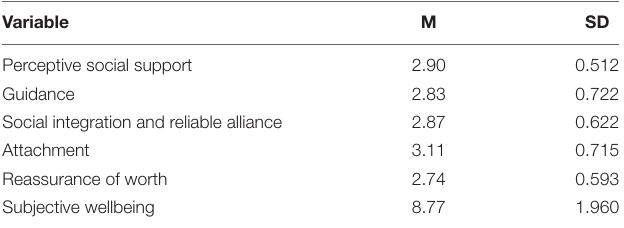
TABLE 2 | Perceived social support and subjective